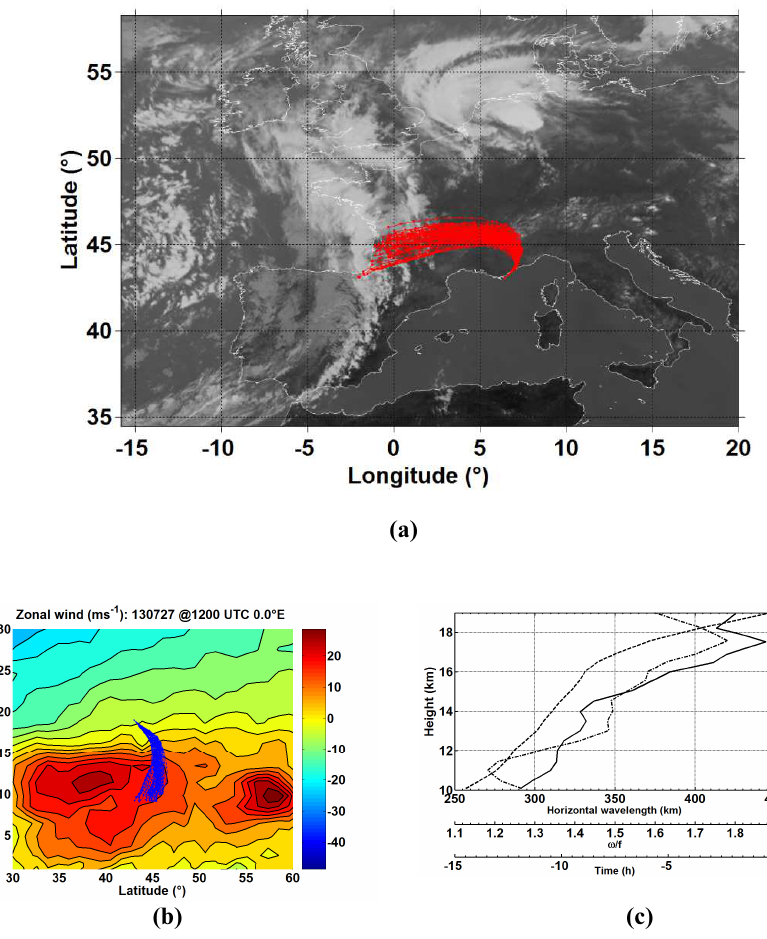
Figure 9. Backward rays from Ile du Levant launched at 19km height on 28 July at 00:00UTC onto (a) georeferenced infrared GMS-3 image and (b) altitude–latitude cross section (colour scale: red relatively high values, blue relatively low values) of zonal wind (ms − 1 ) at longitude of 0.0 ◦ E on 27 July at 12:00UTC. (c) Evolution of horizontal wavelength in units of kilometres (solid line), ω/f (dash-dot line) and time in units of hour (dashed line) as a function of altitude